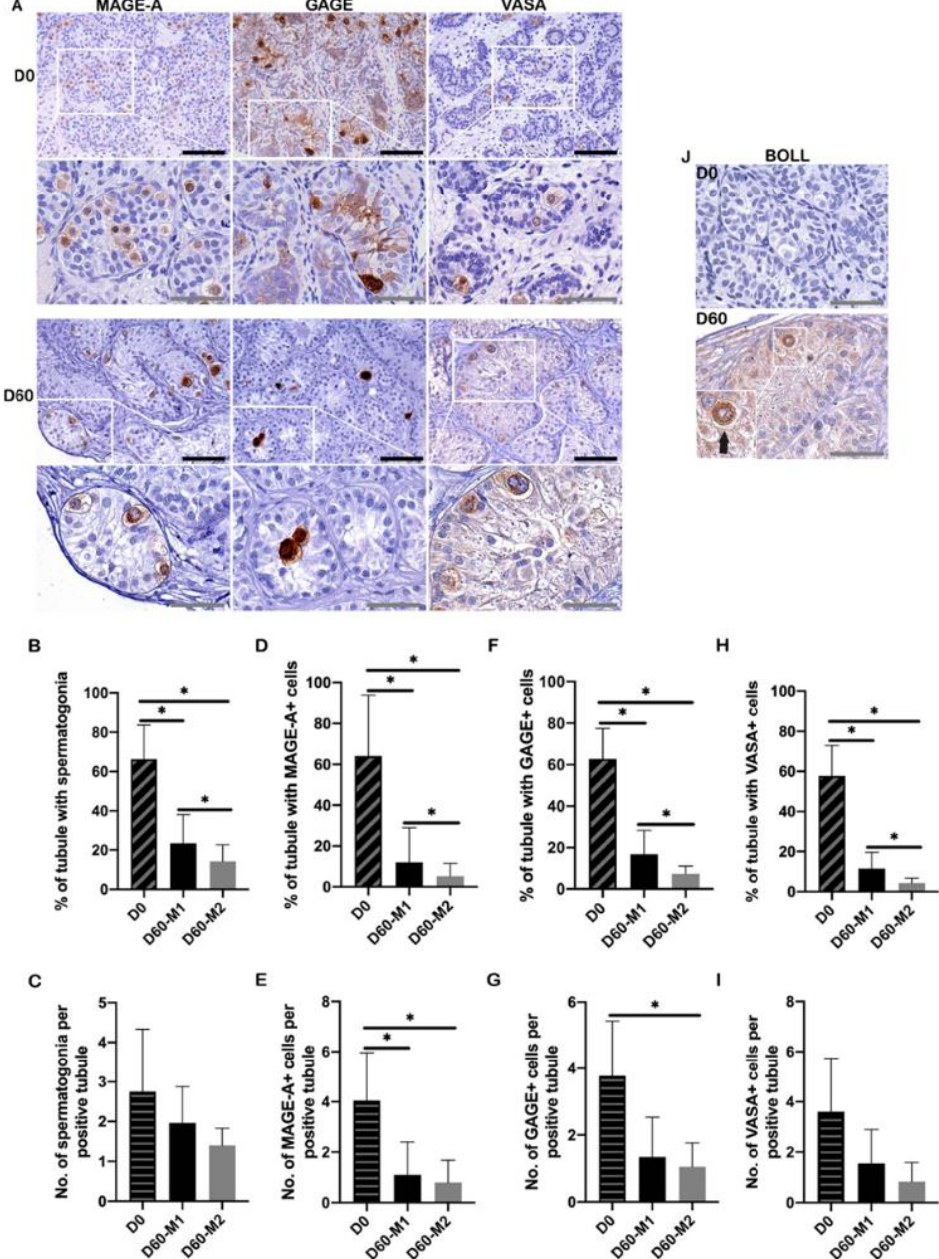
Figure 2. Spermatogonia survival and maturation. ( A ) Immunohistochemical staining of three sper- matogonial markers (MAGE-A, GAGE, VASA) within ITT at D0 and D60. The brown color indicated MAGE-A/GAGE/VASA-positive germ cells. Scale bars: black = 100 µ m; grey bar = 50 µ m. ( B ) Per- centage of tubules with spermatogonia (positive tubule) according to its morphology (PAS staining). ( C ) The number of spermatogonia per positive tubule. ( D ) Percentage of tubules with MAGE-A- positive spermatogonia (positive tubule). ( E ) The number of MAGE-A-positive spermatogonia per positive tubule. ( F ) Percentage of tubules with GAGE-positive spermatogonia (positive tubule). ( G ) The number of GAGE-positive spermatogonia per positive tubule. ( H ) Percentage of tubules with VASA-positive spermatogonia (positive tubule). ( I ) The number of VASA-positive spermatogonia per tubule (positive tubule). ( J ) Immunohistochemical (IHC) staining of BOLL. Positive expression of BOLL after 60-day culture was only observed in M2. The black arrow indicated BOLL positive cell. Scale bar = 100 µ m. Asterisks indicated statistically significant differences.